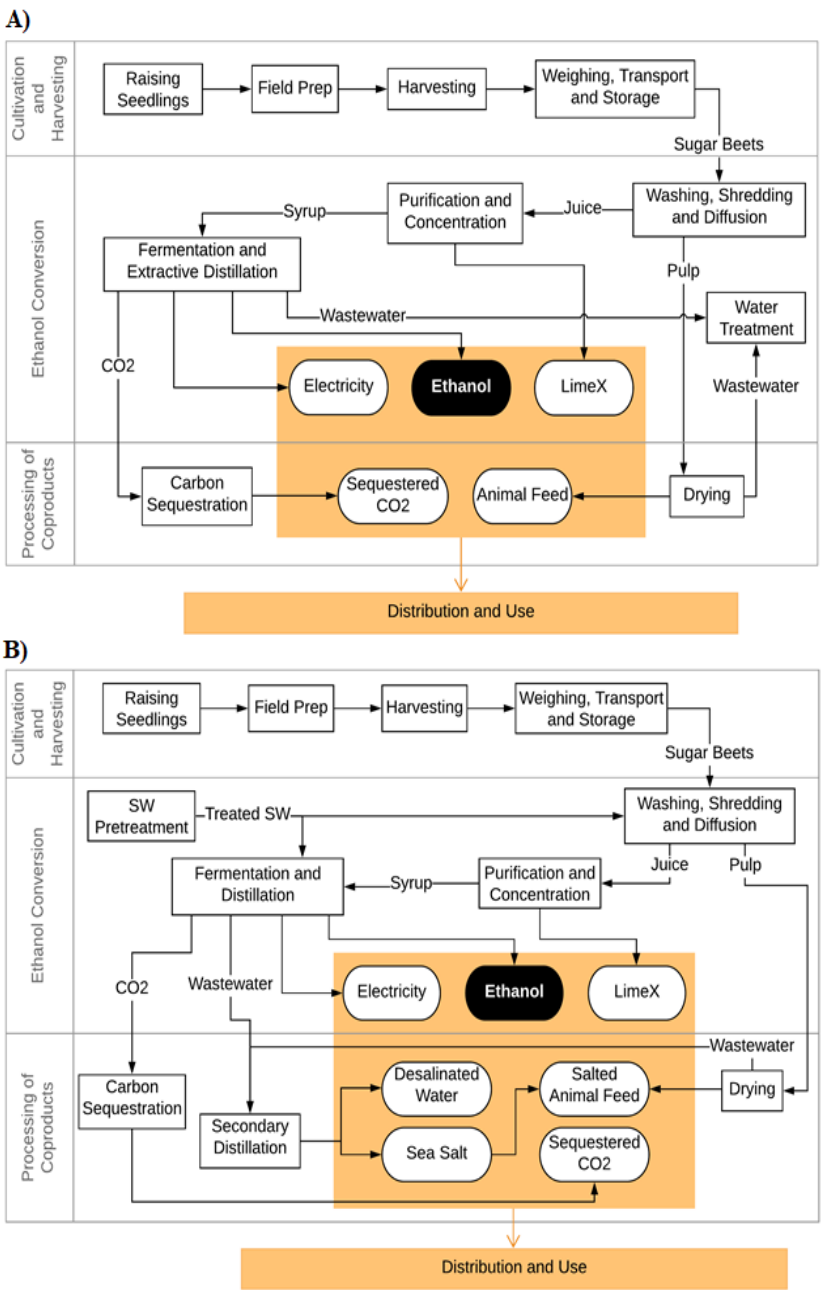
Figure 2. The diagram defining the system boundary of the study, showing the ( A ) Inland Freshwater scenario and ( B ) Coastal Seawater scenario. The inclusions are the intermediate stages (on the arrows), processes (rectangle) and final products (rounded) in the production of bioethanol from sugar beet. The swim lanes of the diagram indicate the subsystems. Production of ethanol (black) along with the coproducts (shaded box) were considered the endpoint for this study. Distribution and use are indicated but not elaborated on as it was not part of the scope of this study.